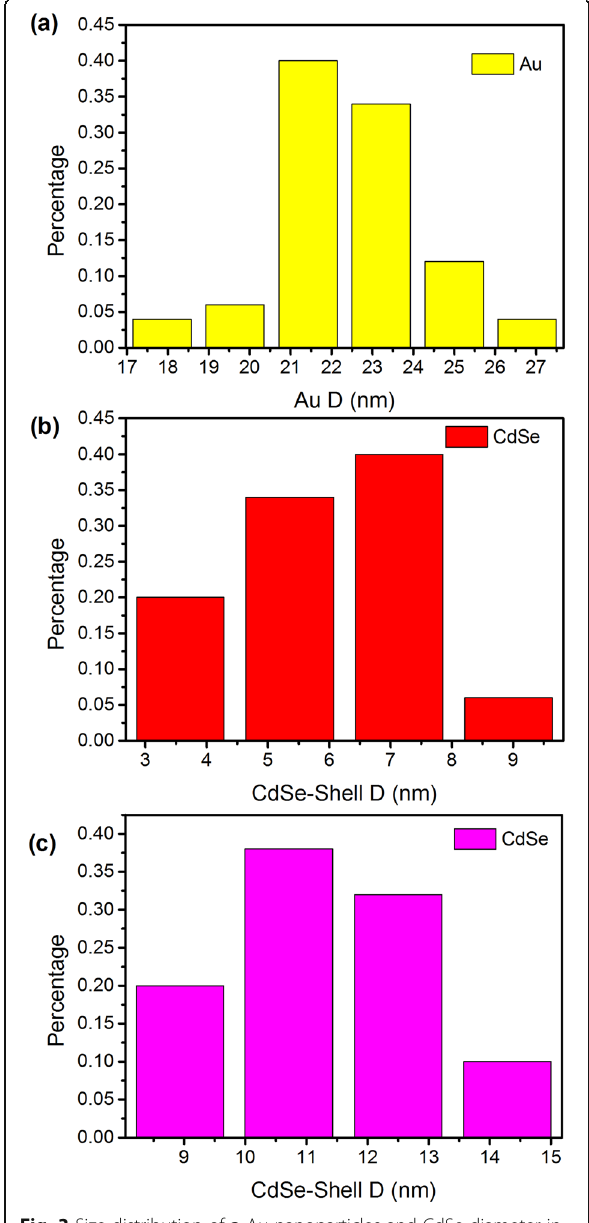
Fig. 3 Size distribution of a Au nanoparticles and CdSe diameter in Au/CdSe Janus nanospheres with different reaction times. b 2 h. c 3 h. The Au/CdSe Janus nanospheres is prepared at pH = 2.5 with 0.05 mL Cd(NO 3 ) 2 (0.1